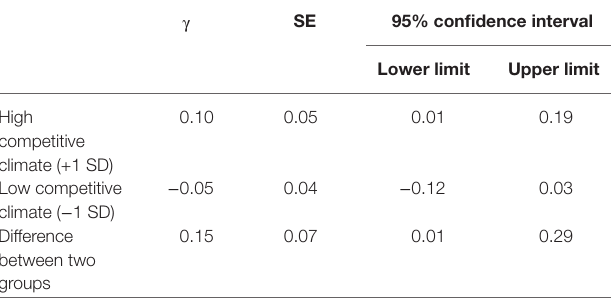
TABLE 6 | Results of the moderated mediation